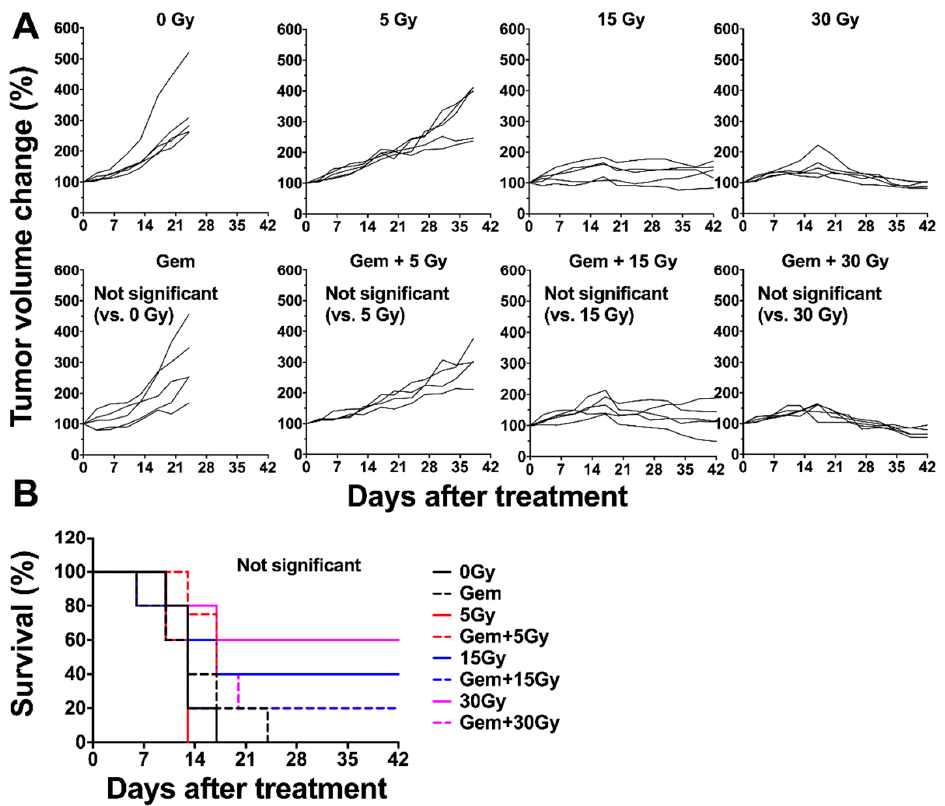
Figure 9. Individual tumor growth curves of BxPC-3 tumors treated with X-ray radiation with or without gemcitabine (gem). 0 Gy, gem (240 mg/kg body weight) alone, 5 Gy, gem plus 5 Gy, 15 Gy, gem plus 15 Gy, 30 Gy, and gem plus 30 Gy shown in the ( A ). Tumor size was measured at least twice a week. Survival curves were plotted based on the endpoint of 150% tumor volume ( B ).